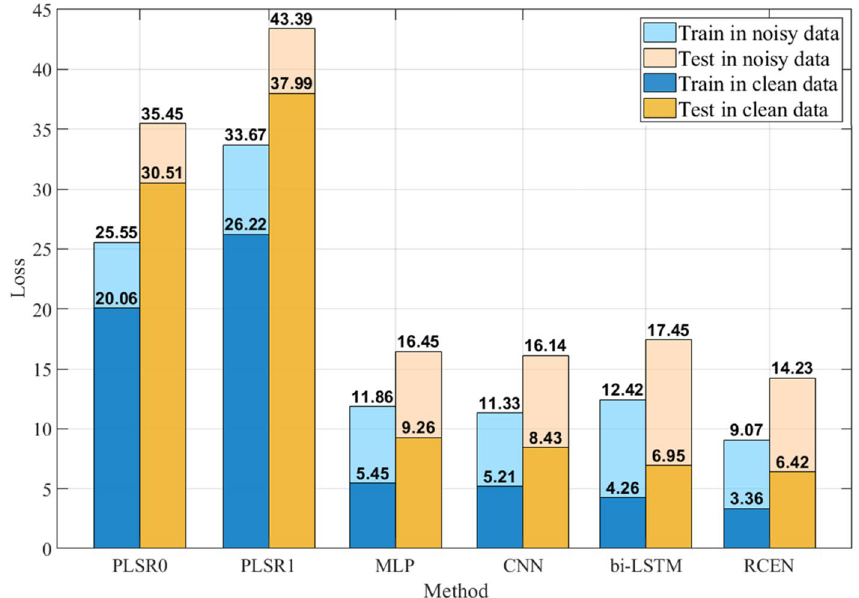
Figure 6. Estimation performance of the different methods for modeling the cable effect.